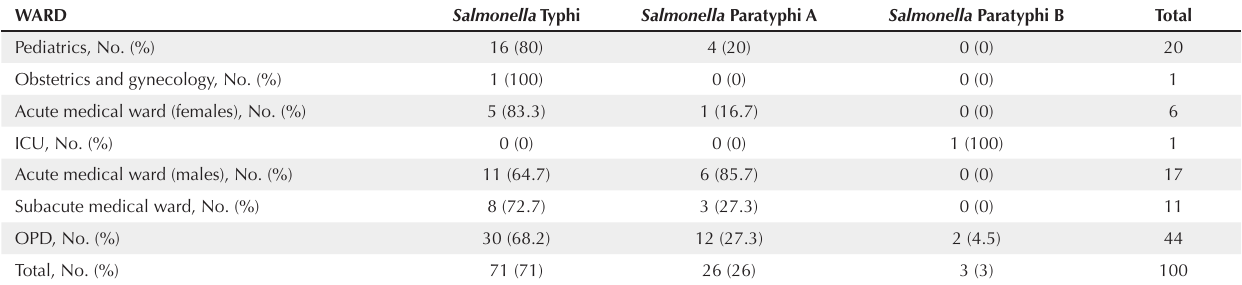
Table 1. Distribution of Salmonella Typhi, Salmonella Paratyphi A, and Salmonella Paratyphi B in Blood Samples From Various Wards WARD